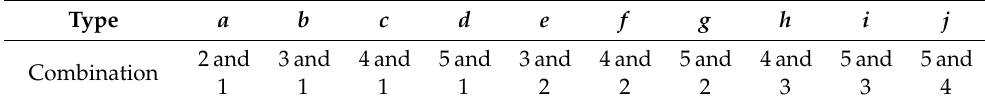
Table 3. Irradiation combinations and